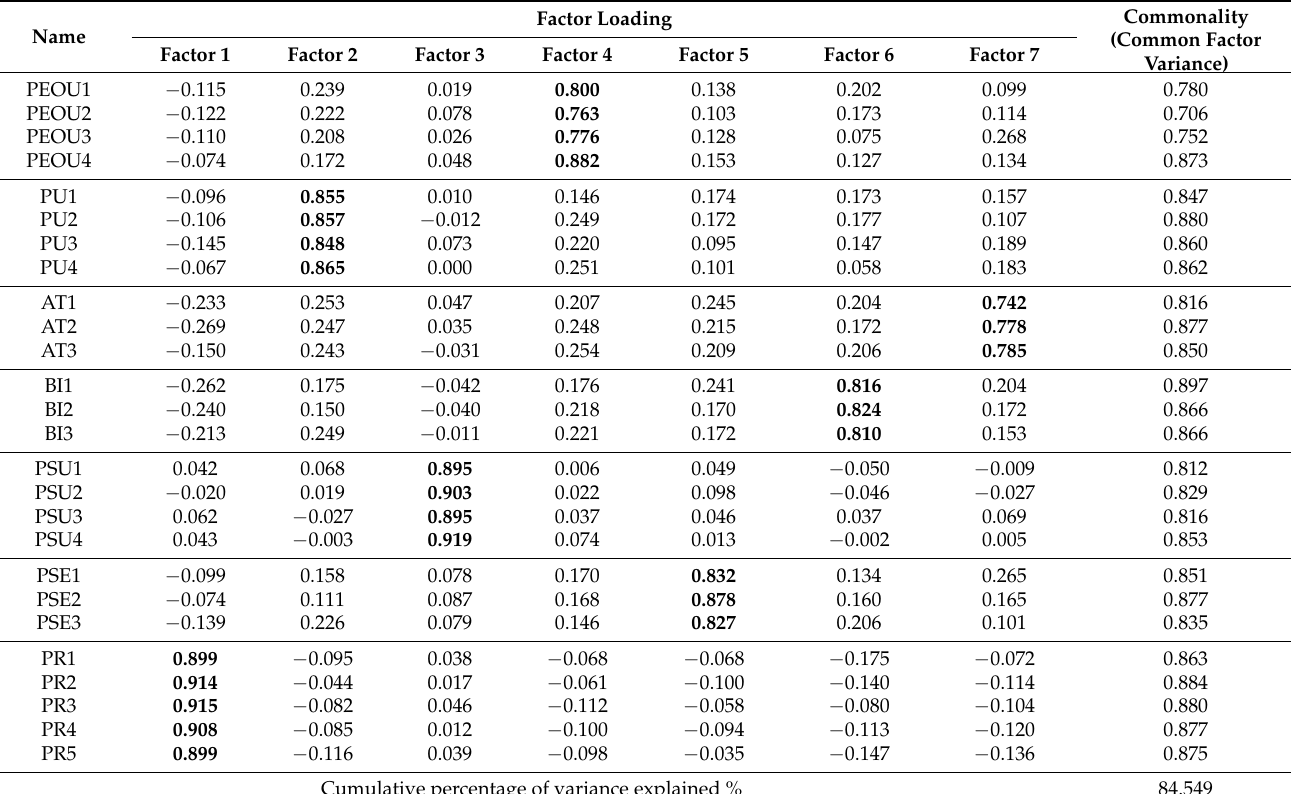
Table 5. Factor loadings